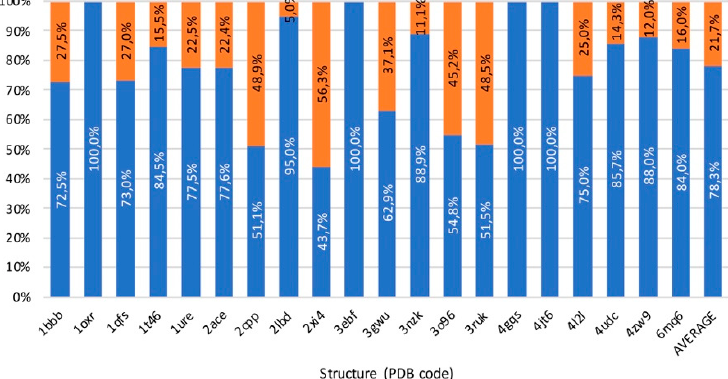
Figure 11. Summary of benchmark results. In blue, percentage of solutions that belong to already referenced pathways. In orange, percentage of solutions that belong to other pathways.